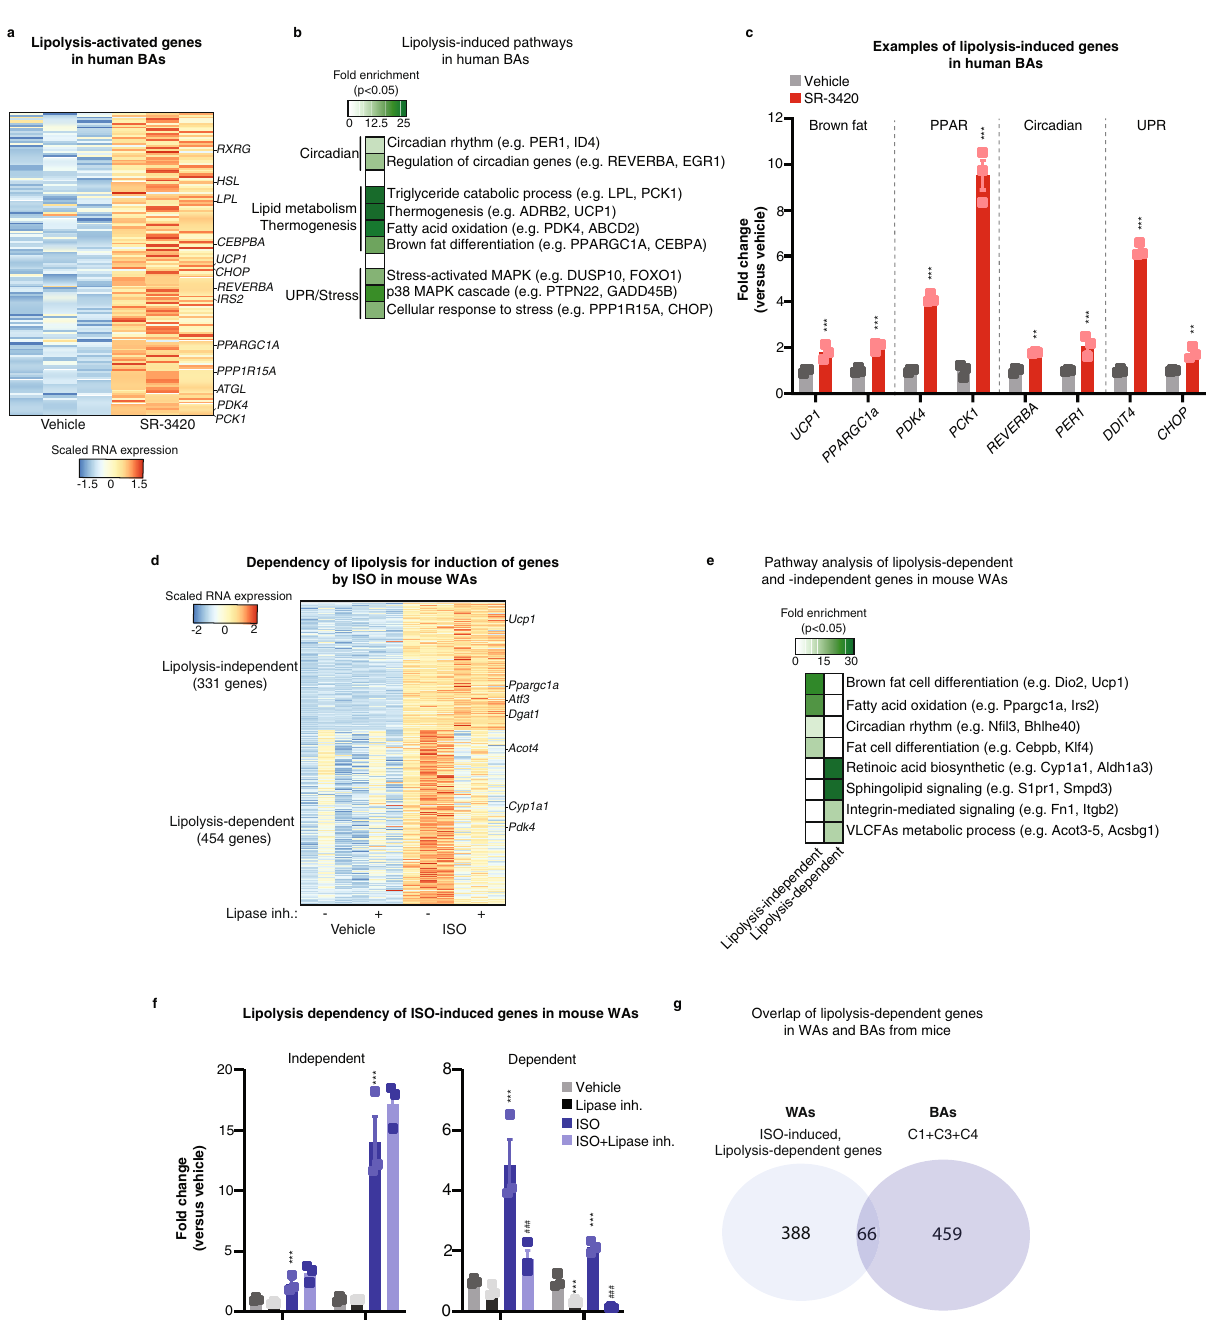
Fig. 7 Lipolysis activates overlapping gene programs in human brown adipocytes. a Heatmap of RNA-seq data showing lipolysis-activated genes (Log2FC ≥ 0.7, FDR/Benjamini – Hochberg ≤ 0.05) in human in vitro differentiated brown adipocytes. Cells were stimulated with 20 µ M SR-3420 or vehicle for 3h before harvest. n = 3 biologically independent experiments examined, each carried out in a technical duplicate. b Pathways signi fi cantly enriched (FDR ≤ 0.05) among lipolysis-activated genes in a . c Examples of lipolysis-activated genes derived from RNA-seq belonging to enriched pathways in b . d Heatmap of RNA-seq data showing dependency of lipolysis for induction of genes by ISO Log2FC ≥ 1, FDR/Benjamini-Hochberg ≤ 0.05) in white adipocytes. Mature mouse white adipocytes were isolated from epididymal white adipose tissue and cultured in a 3D matrix for 2 days. After 2 days, cells were pre-treated with 10 µ M Atglistatin (ATGL inhibitor) and 20 µ M CAY10499 (HSL inhibitor) for 1h and subsequently with 20 µ M SR-3420 for 3h before harvest. n = 3 biologically independent experiments examined, each carried out in a technical duplicate. e Pathways signi fi cantly enriched (FDR ≤ 0.05) among lipolysis-dependent and -independent ISO- activated genes in d . f Examples of lipolysis-dependent and -independent ISO-activated genes derived from RNA-seq in d . n = 3 biologically independent experimentsexamined,eachcarriedoutinatechnicalduplicate. g Venn diagramillustratingtheoverlapoflipolysis-dependentgenesinmousewhite( d )andbrown adipocytes (Fig. 1d). For all panels, error bars represent ±SEM of 3 independent biological experiments. Statistical signi fi cance was determined by using FDR/ Benjamini-Hochberg correction for Fig. 1f ( p ≤ 0.05 = *, p ≤ 0.01 = **, p ≤ 0.001 = ***). * versus Vehicle, # versus ISO (without Lipase